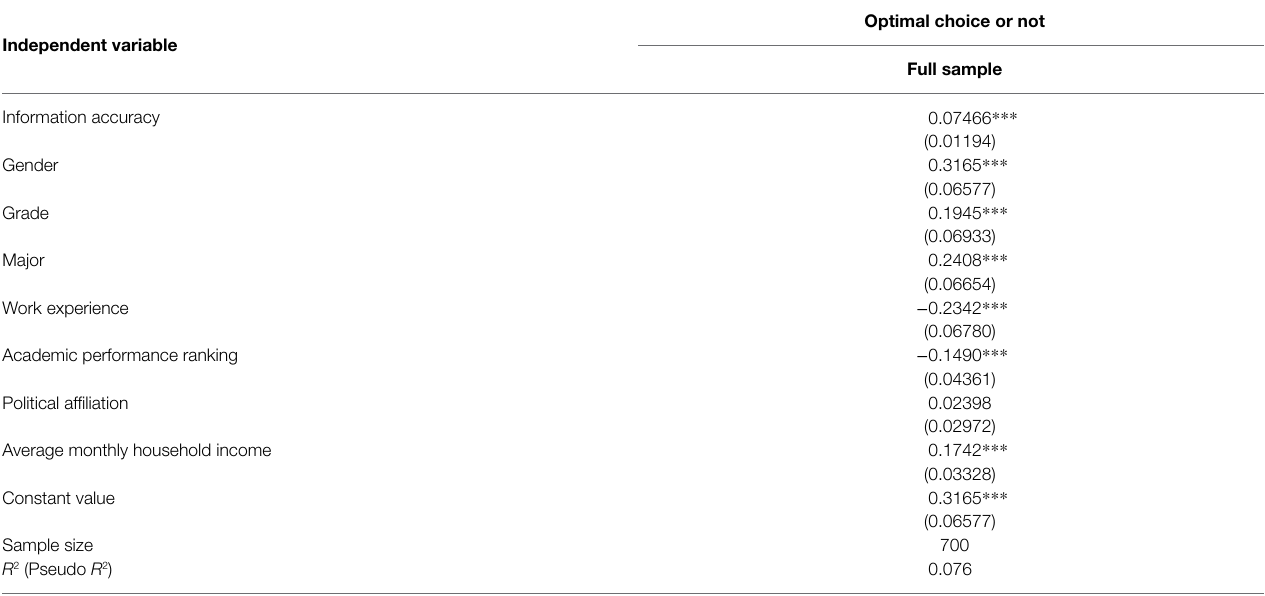
TABLE 2 | Regression analysis of information search behavior.